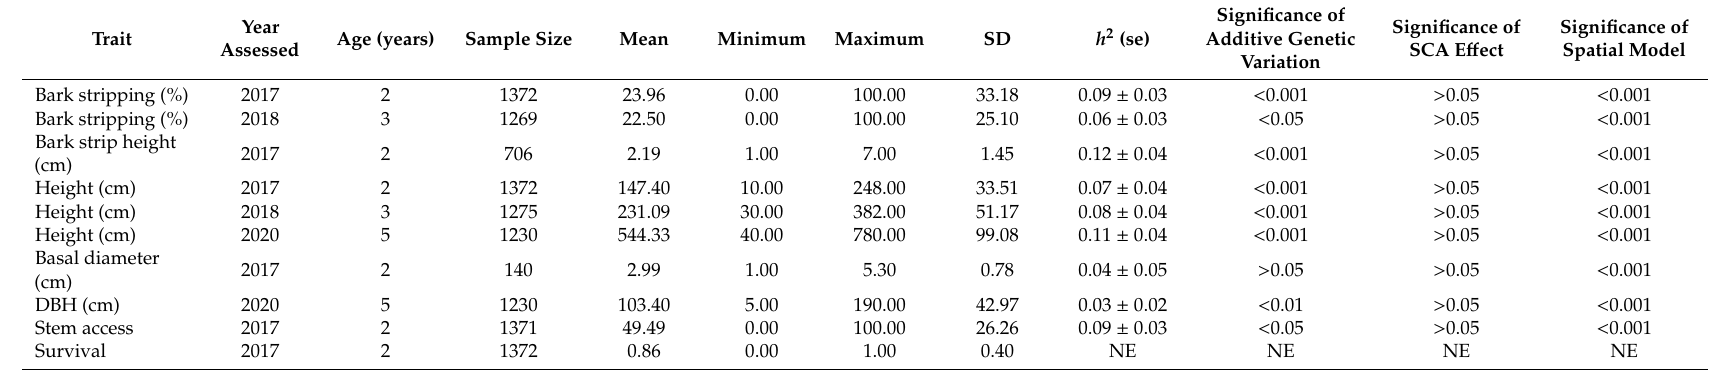
Table 4. Statistics for each trait assessed at Wilmot. SD = standard deviation; h 2 (se) = narrow-sense heritability and its associated standard error estimated with univariate spatial models. The significance of the additive genetic variation and specific combining ability (SCA) and the spatial e ff ect on the model are also presented. Genetic variation was not estimated (NE) for survival, since it was high for most families.